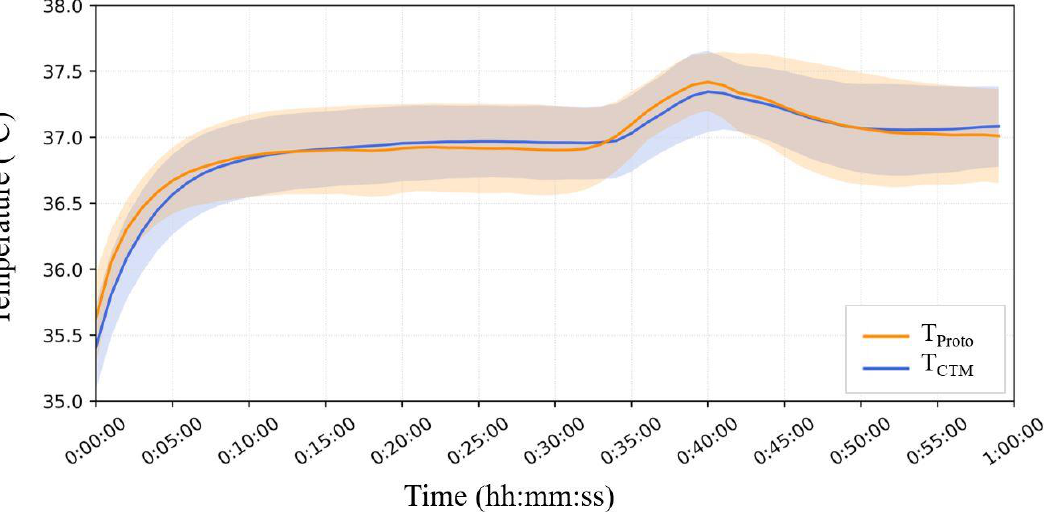
Figure 8. The means and error bands of the measurement results of all four subjects of the ergometer test.